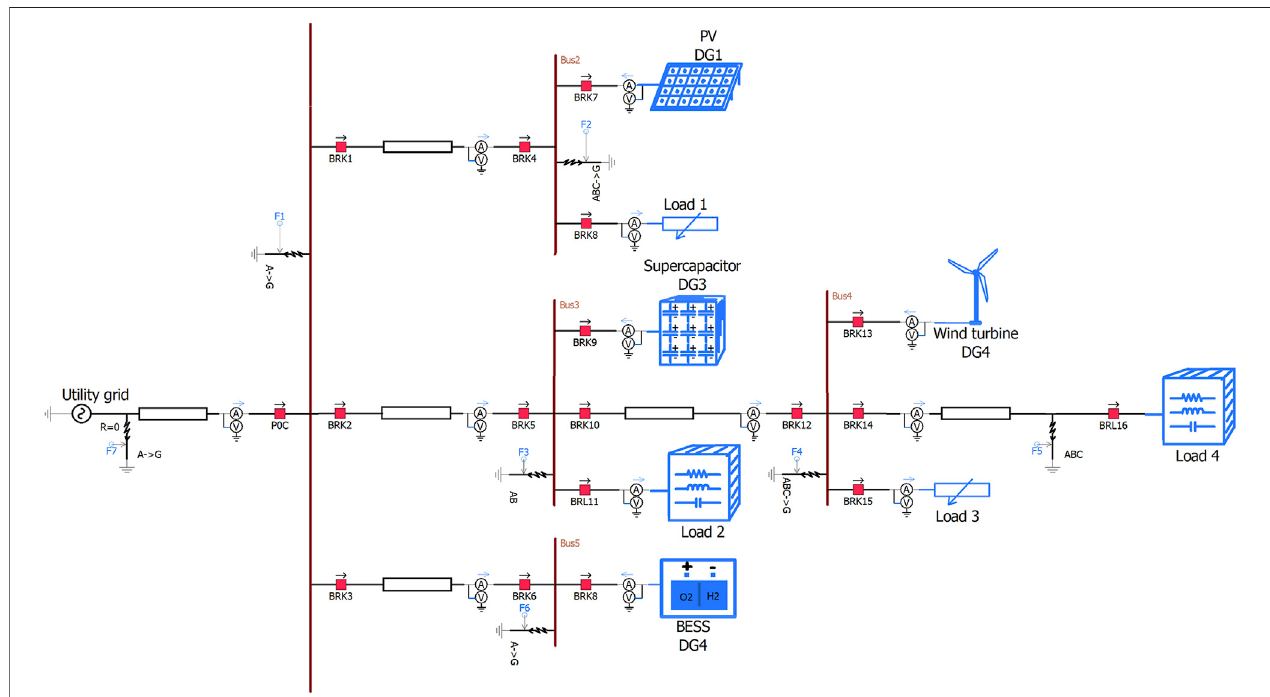
FIGURE 2 | Single-line schematic diagram of the studied low-voltage active distribution network.